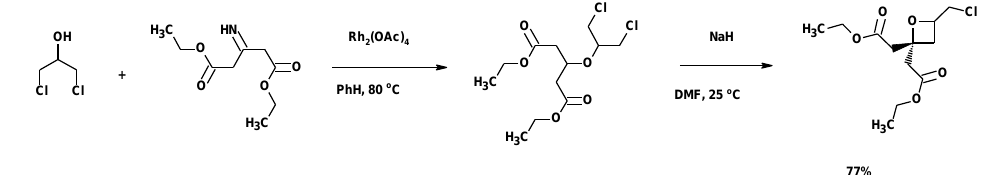
Figure 21. Synthesis of oxetane rings described by Davis et al. [169].